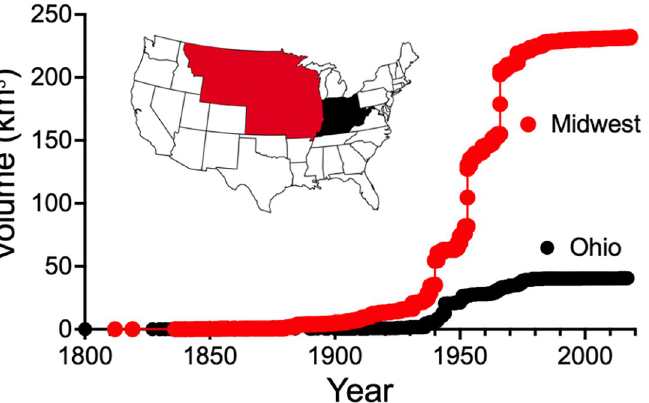
Fig 8. The volume of water stored behind dams and reservoirs in twelve states in the Midwest (Missouri River and Upper Mississippi River watersheds in red) and five states including the Ohio River watershed (in